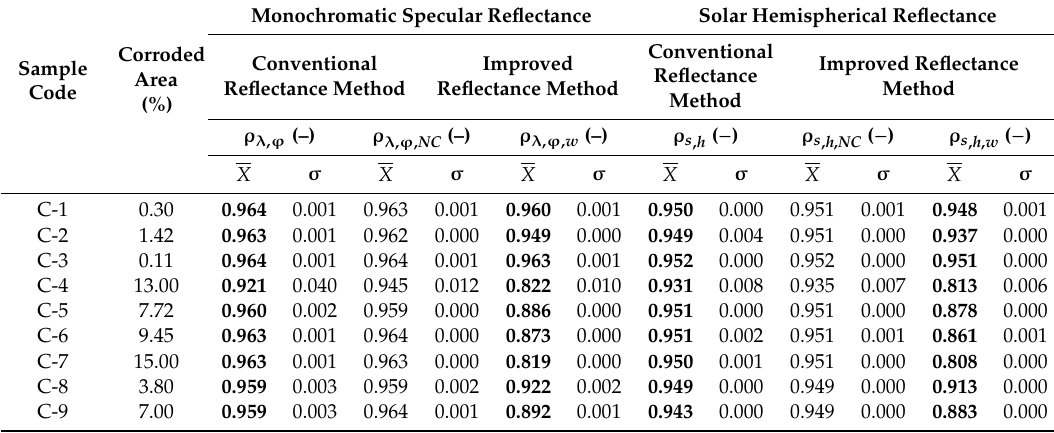
Table 3. Results of the corroded area and the monochromatic specular and solar hemispherical reflectance values for both reflectance measurement techniques, applied to the corroded samples aged in the CASS